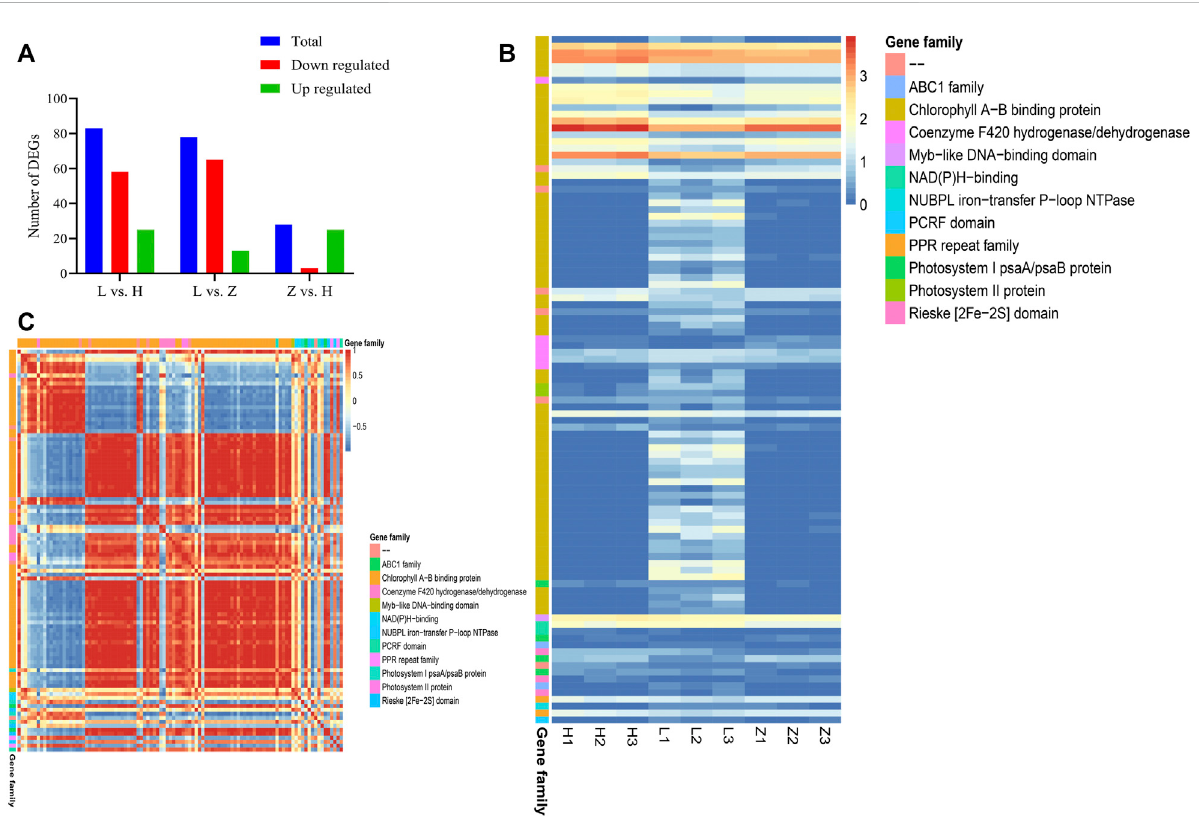
FIGURE 7 Characterization of DEGs associated with the chlorophyll contents. (A) statistics for chlorophyll-related DEGs in three comparisons between green, yellow, and purple leaves, viz ., L vs. H, L vs. Z, and Z vs. H. (B) heatmap of 151 chlorophyll-related DEGs based on corresponding FPKM values. (C) correlation plot representing PCC between 101 chlorophyll-related